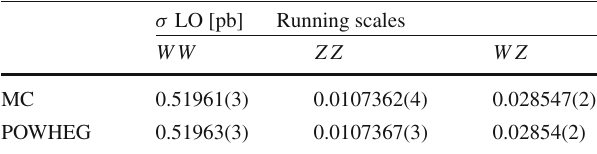
Table 3 Integrated cross sections for the processes pp → e + ν e μ − ν μ ,